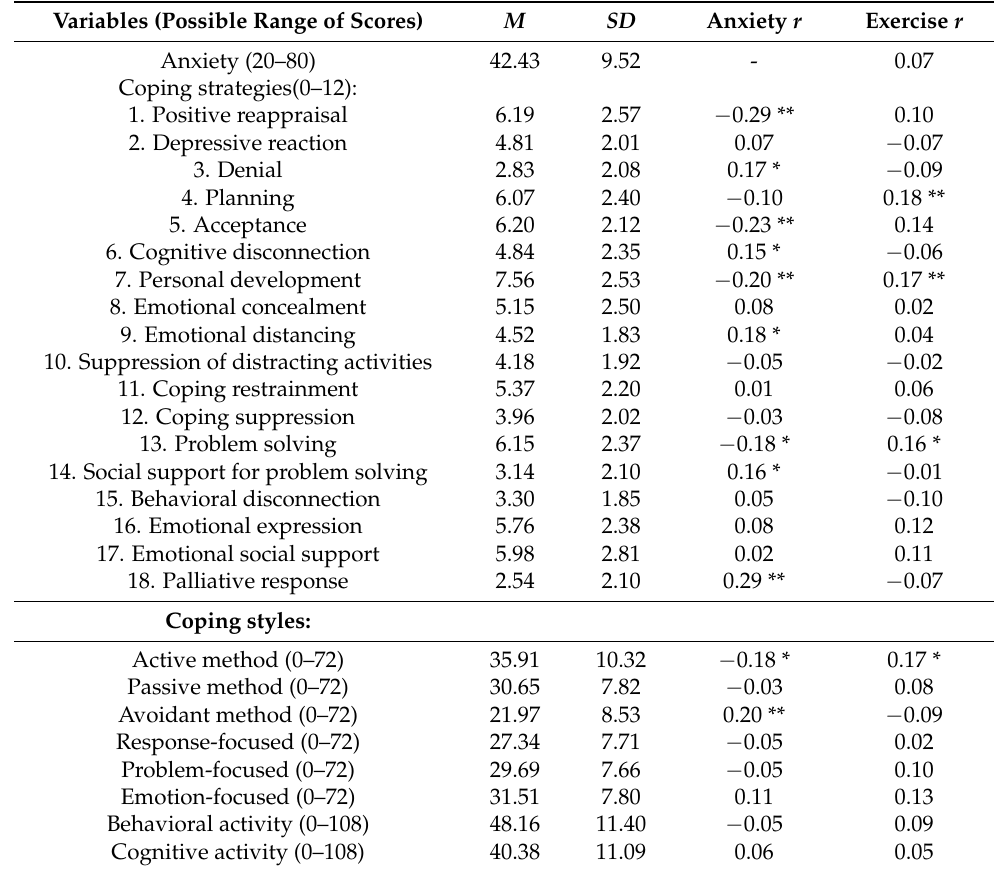
Table 2. Descriptive data and correlations between anxiety, coping strategies and styles and physical